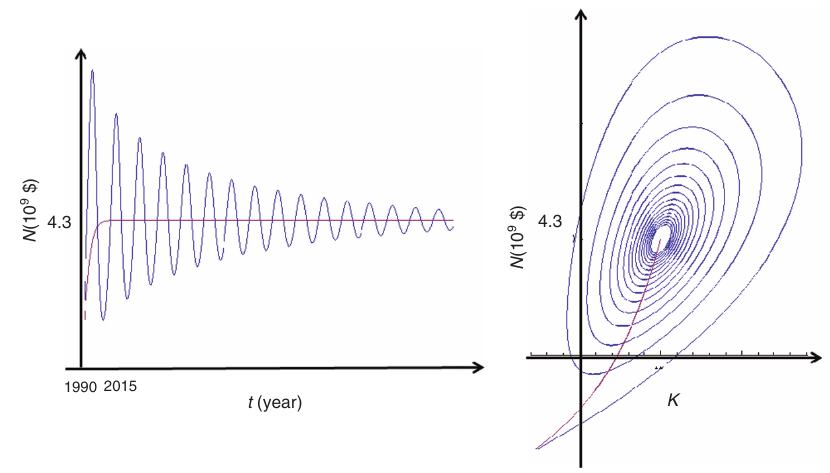
Figure 4 Time delay τ = 3 years and the corresponding phase diagram.